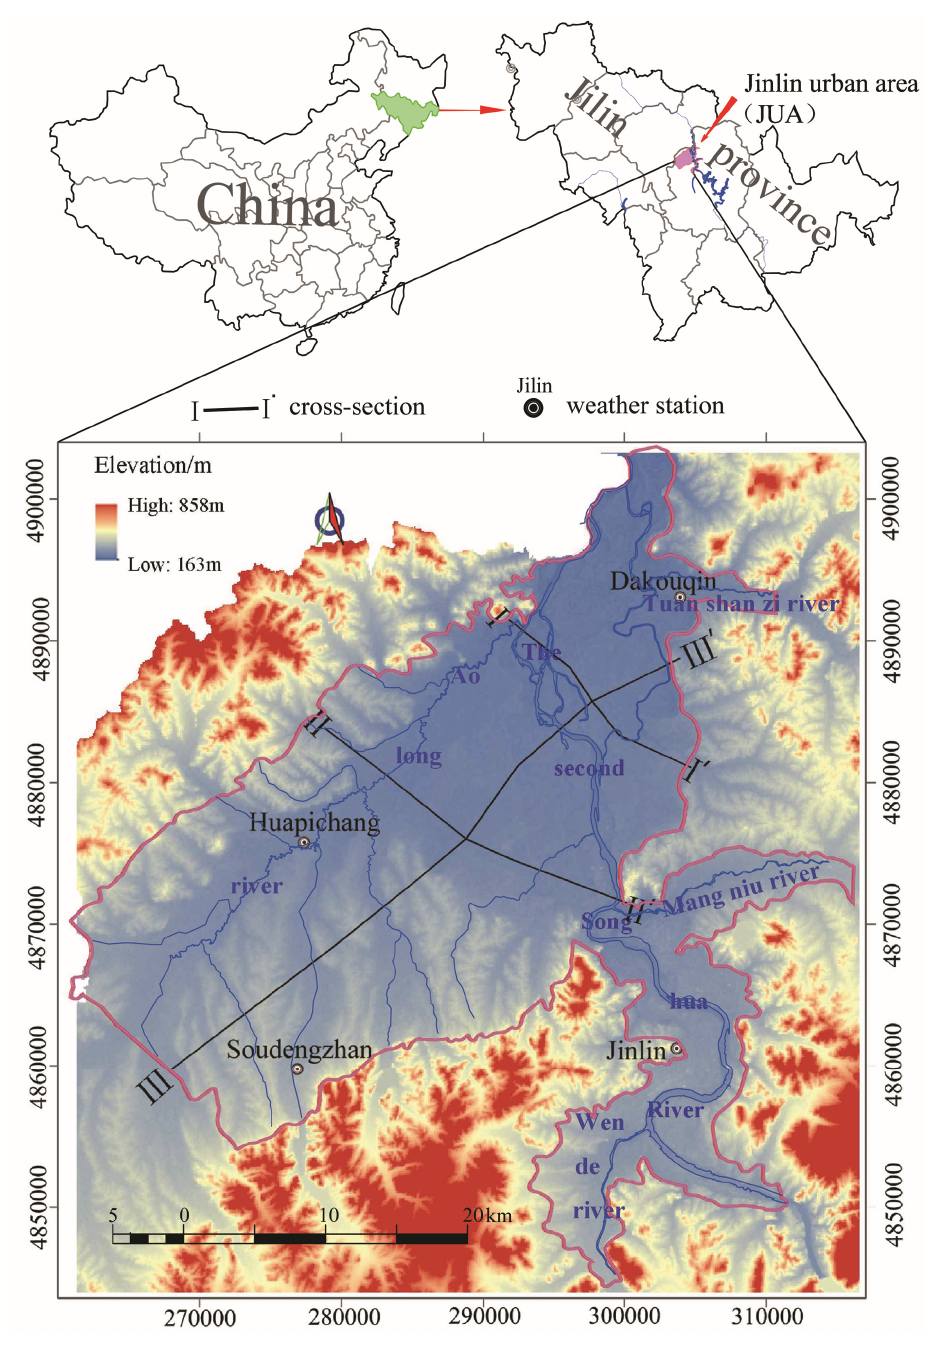
Figure 1. Location of Jilin urban area